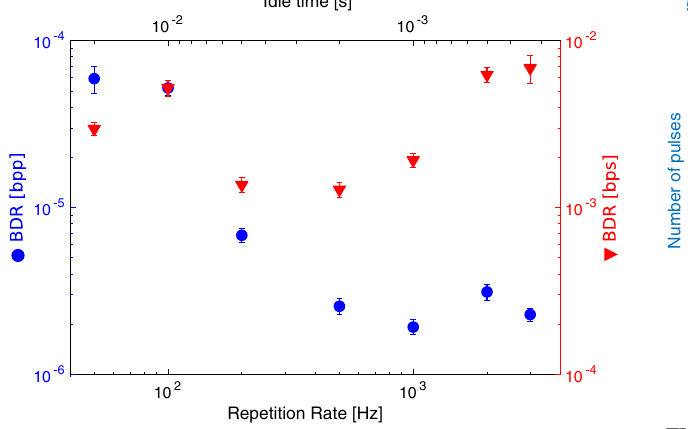
FIG. 10. BD experiments of Fig. 6(a) repeated, but now measured in decreasing order of repetition rates. The figure shows the BDR as BDs per pulse and as BDs per second for each repetition rate. The uncertainties were estimated using the standard error of the mean, though many of the error bars are too small to be visible.